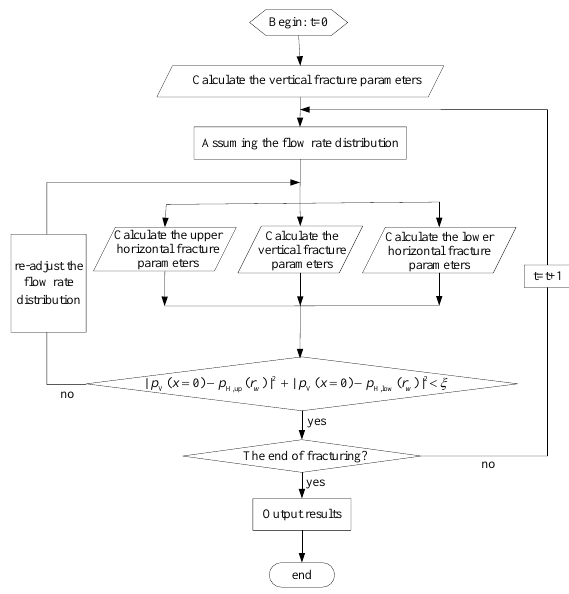
Figure 3. The flow chart of the numerical method.